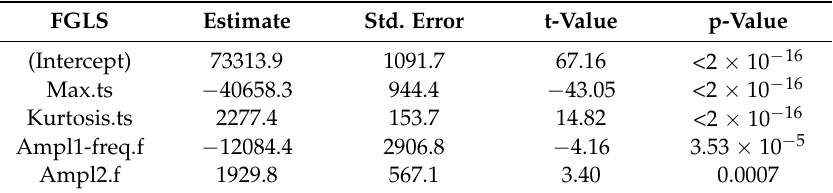
Table 7. Coefficient estimation of FGLS of testing dataset k = 1.